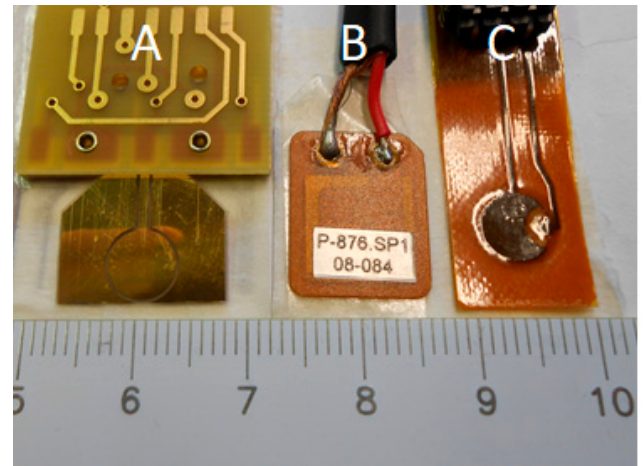
Figure 4. Example of three different type of piezoelectric sensor for SHM: ( A ) circular polyvinylidene fluoride (PVDF) sensor made with bioriented PVDF film furnished by Precision Acoustics, ( B ) BaTiO 3 piezocomposite, model DuraAct produced by Physik Instrumente, and ( C ) piezoelectric wafer active sensors (PWAS), model SML-SP produced by Acellent.